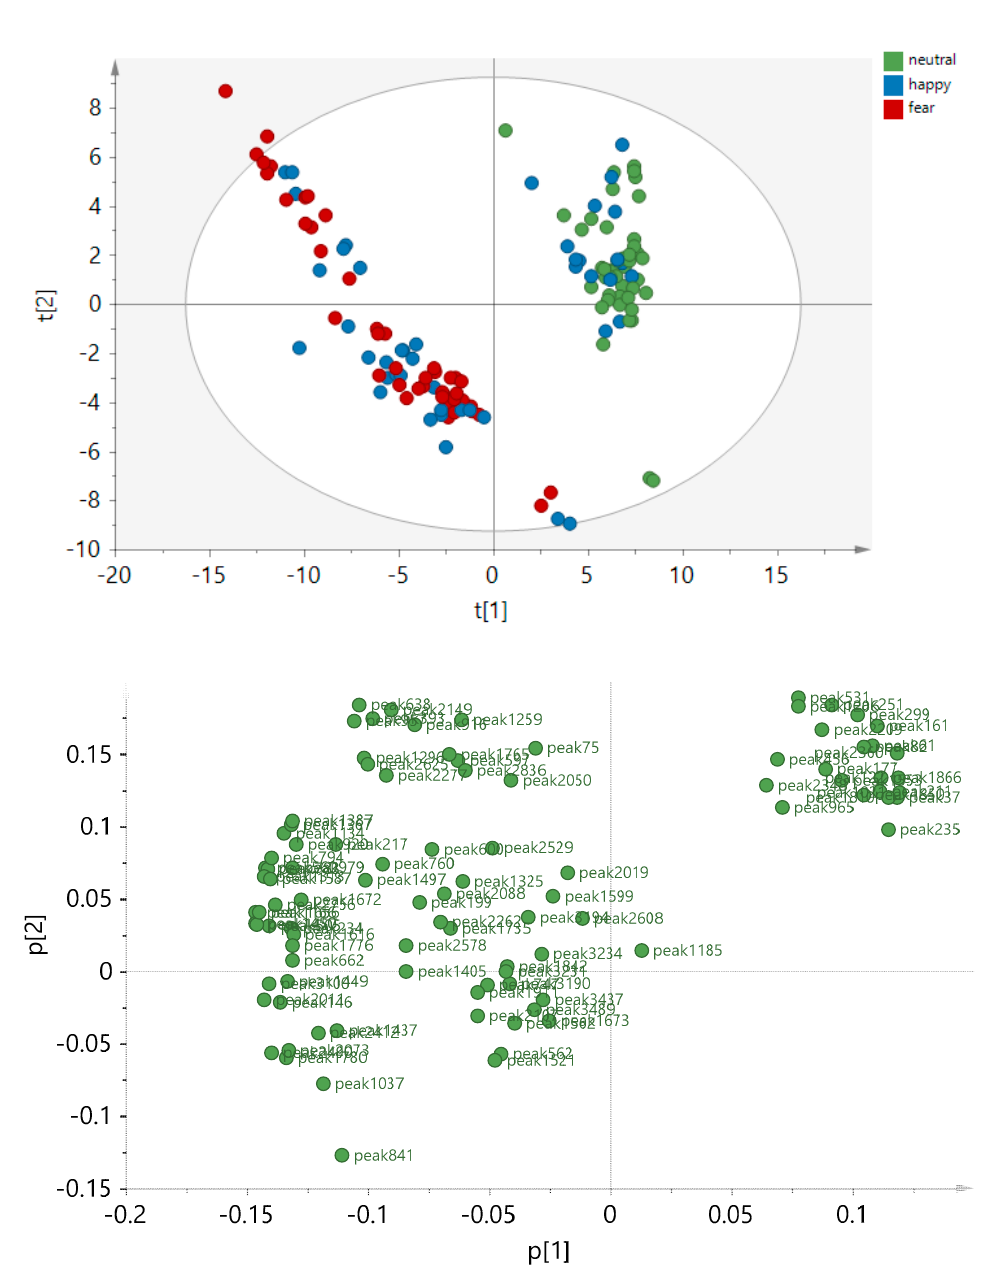
Figure 3. Principal component analysis (PCA) score plot based on 135 sweat samples and 94 peak areas that were significantly discriminating the condition groups in the PLS-DA models. The principal components t[1], t[2] are displayed, explaining R2X[1] = 0.437 and R2X[2] = 0.141 of the variances, respectively. The data were not normalized and Pareto scaling was applied.